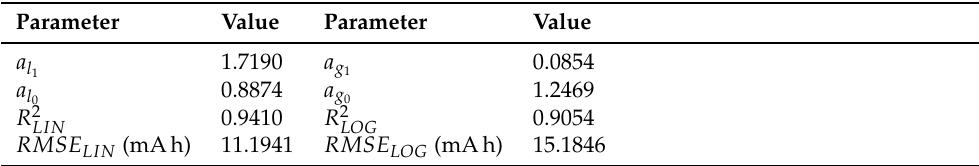
Table 4. Values of a l , a l , R 2 , and RMSE calculated for calculated for all batteries in Set A and values 0 1 of a g , a g , R 2 , and RMSE for all batteries in Set B 0 1